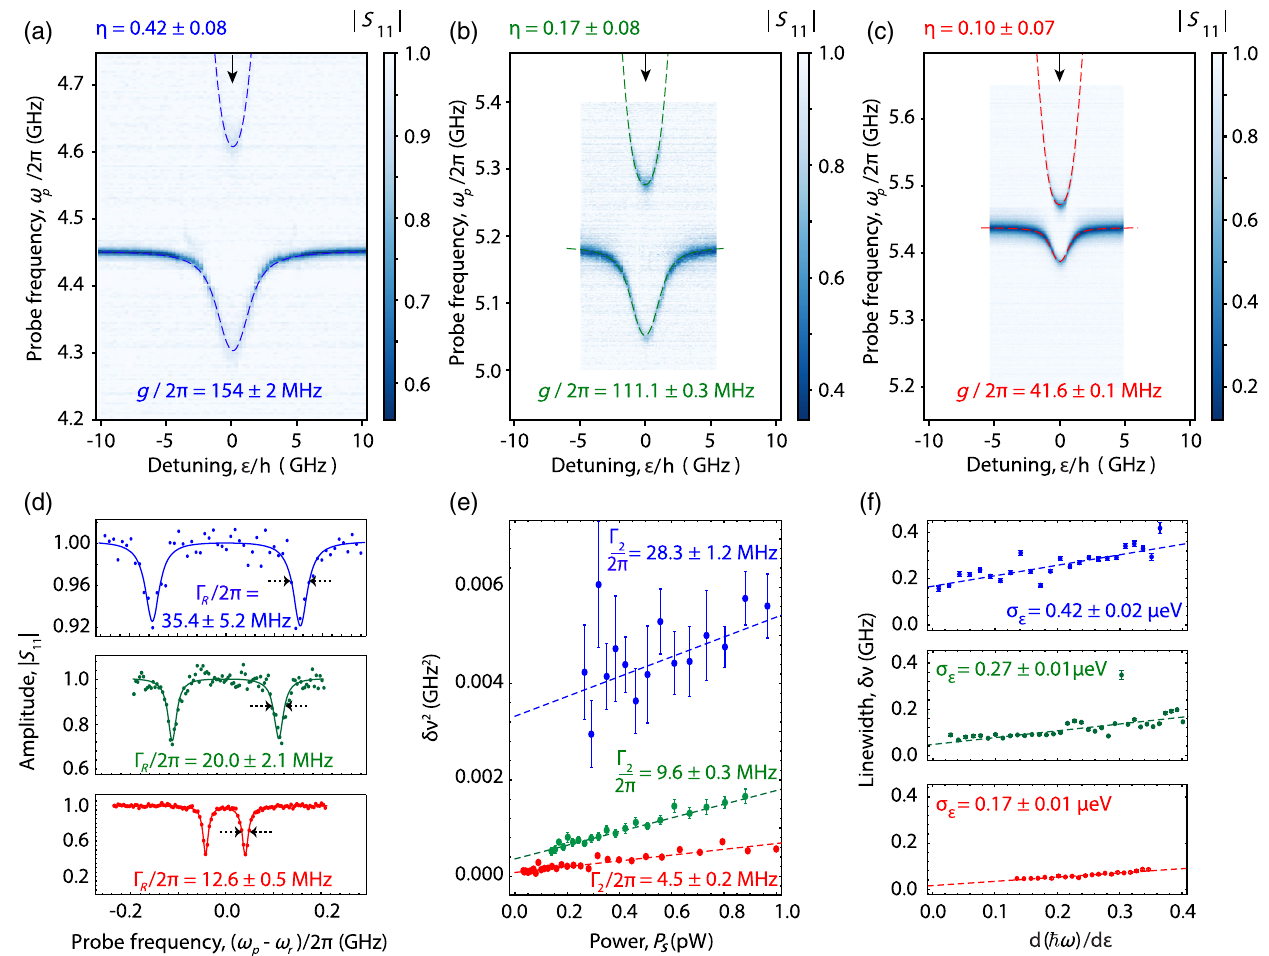
FIG. 3. The dependence of the coupling strength g and DQD coherence rates Γ and Γ 2 for DQD configurations with dipole strengths R η ¼ 0 . 42 , 0.17, 0.10. (a) – (c) Resonator reflectance amplitude j S ϵ for three representative values of the dipole 11 j versus DQD detuning strength η ∼ 0 . 42 (cid:3) 0 . 08 (blue curve), η ∼ 0 . 17 (cid:3) 0 . 08 (green curve), and η ∼ 0 . 10 (cid:3) 0 . 07 (red curve) [corresponding to the DQD charge stability diagrams in Figs. 2(c), 2(b), and 2(a), respectively]. (d) Resonator amplitude response j S 11 j (dots) versus probe = 2 π at ϵ ¼ 0 [see the black arrow in (a) – (c)], displaying well-resolved vacuum Rabi mode splittings. The solid line is a fit frequency ω p is computed as an average of the two linewidths. (e) Squared qubit linewidth δν 2 to the sum of two Lorentzian lines. The quoted Γ q R (dots) versus spectroscopy drive power P , measured via two-tone spectroscopy [10]. The dashed lines are linear fits. The zero-power s linewidths Γ 2 are given. (f) Qubit linewidth δν (dots) versus d ð ℏ ω Þ =d ϵ extracted from two-tone spectroscopy [10]. The dashed lines are q linear fits. Their slopes define σ ϵ according to Eq.